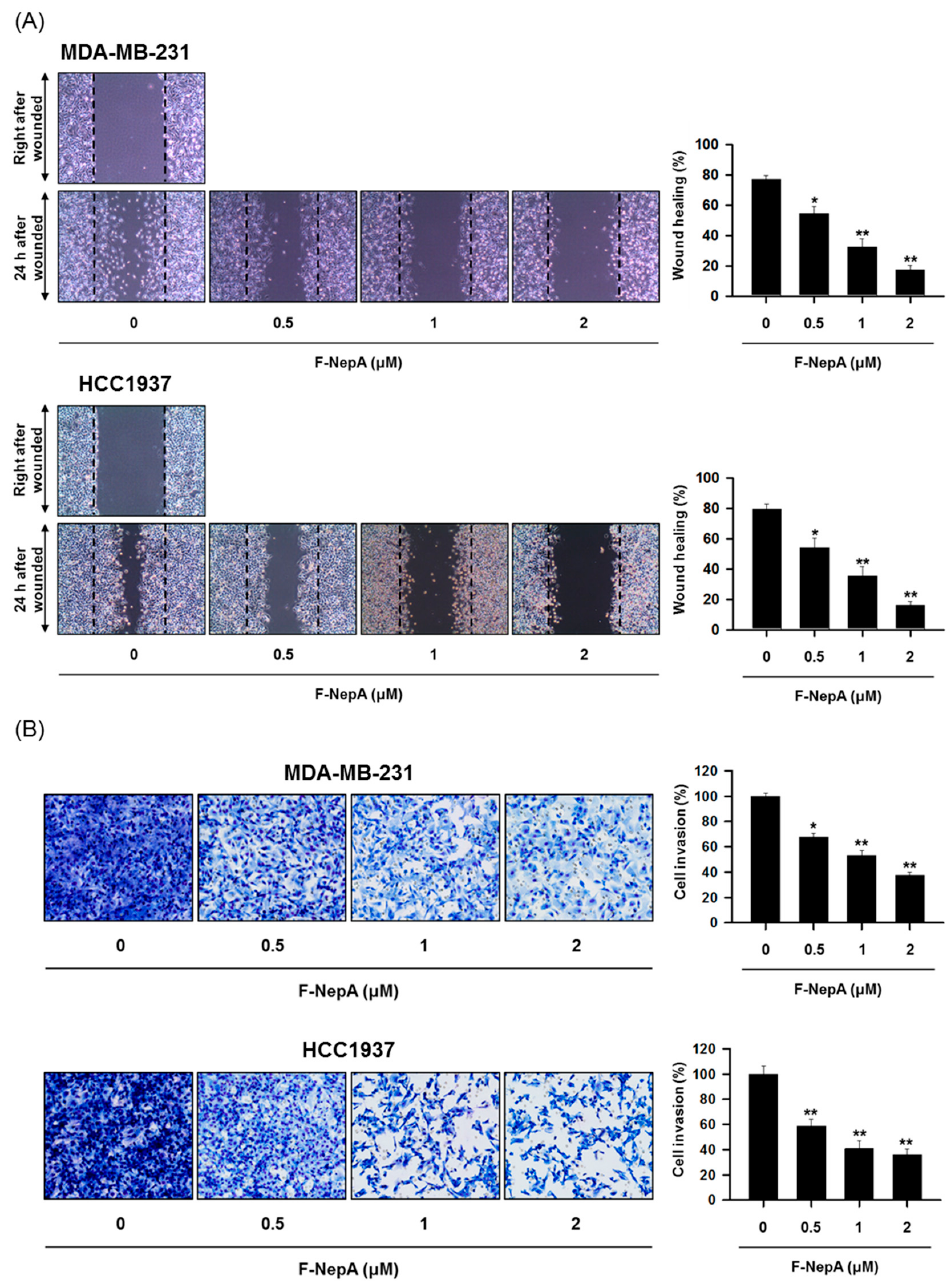
Figure 4. Regulatory effects of F-NepA on the migration and invasion potential of human TNBC cells. ( A ) Monolayers of MDA-MB-231 and HCC1937 cells were scratched mechanically and treated with F-NepA for 24 h. Representative images of wound closure obtained under a light microscope are shown (left). The areas of the wounds were quantified using ImageJ (right). ( B ) MDA-MB-231 and HCC1937 cells were pretreated with F-NepA at the indicated concentrations for 24 h, reseeded into the upper chambers of Transwell inserts, and incubated for 24 h. The cells that invaded the lower chambers were fixed, stained, imaged (left), and counted (right). * p < 0.05 and ** p < 0.01 indicate significant differences relative to the vehicle-treated control group.